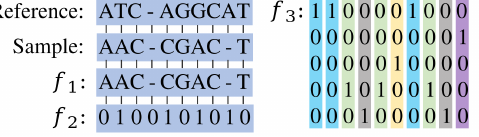
Figure 3. Examples of the three data structures applied in this study. f 1 is basically the same as the sample, and the unknown nucleotides in the sample are replaced with nucleotides at the corresponding locations in the reference sequence. f 2 is obtained by aligning the sample sequence with the reference sequence, thereby highlighting the mutation sites. f 3 has the largest amount of data, and each site is represented by a 5 × 1